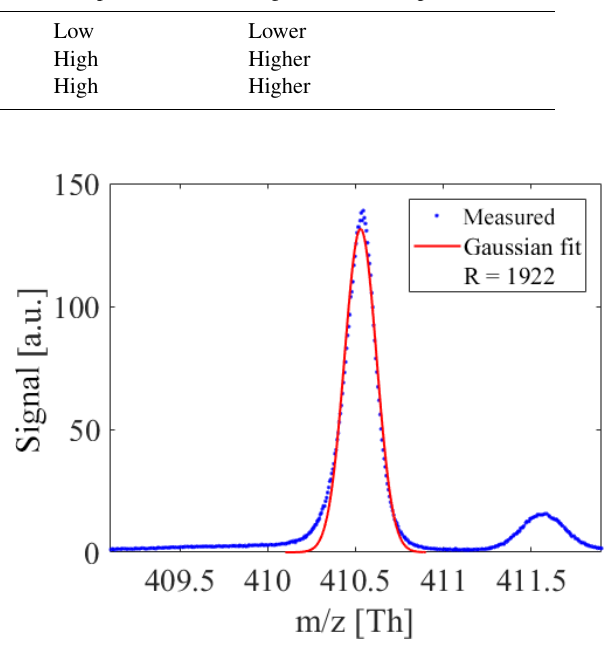
Figure 2. The mass resolution of the ioniAPi-TOF is about 2000 at a nominal mass of 410Th, which corresponds to C 28 H 60 N + , the THABr